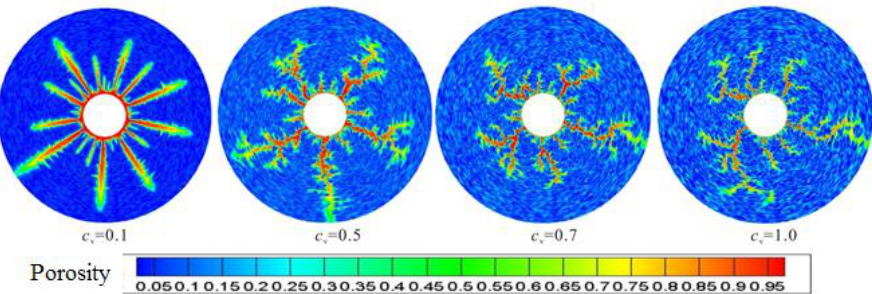
Figure 11. Effect of pore space distribution on wormhole morphology.